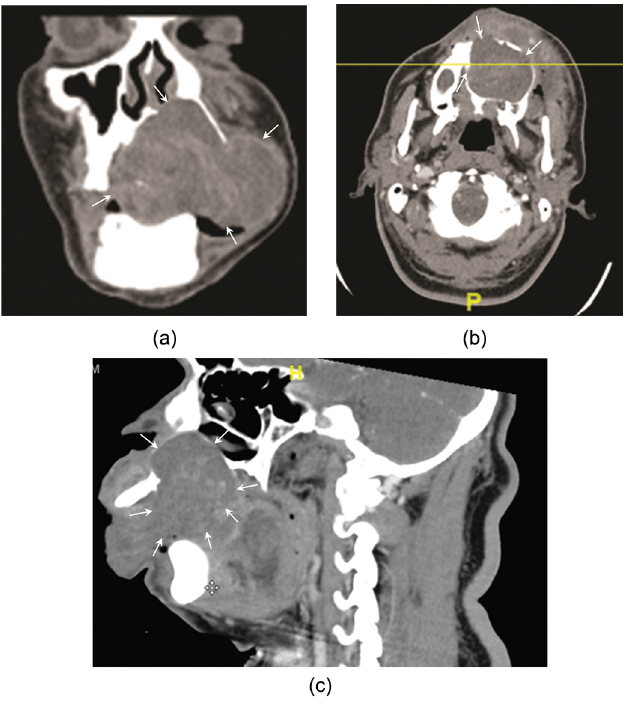
Fig. 2. Case 2. Coronal (a), axial (b), sagittal (c) images of computed tomography scan. Well de fi ned, large expansile mass at the left maxilla with extension into the maxillary antrum, nasal cavity and surrounding soft tissues (white